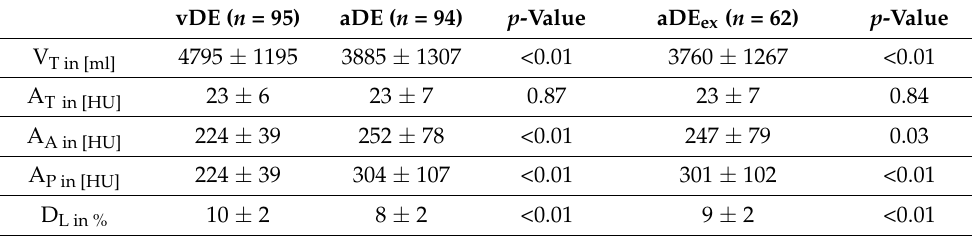
Table 2. Objective image quality of the study (vDE—portal-venous thoraco-abdominal Dual Energy CT), the reference (aDE—pulmonary arterial Dual Energy CT), and the subgroup of the reference with exclusion of cases with pulmonary embolism (aDEex): Total lung volume (VT); mean relative attenuation of the lung parenchyma (AT), ascending aorta (AA), and pulmonary trunk (AP); and distribution ratio (DL) of contrast agent between the large vessels and the lung parenchyma. vDE ( n = 95) aDE ( n = 94) p -Value aDE ex ( n = 62) p -Value V T in [ml] 4795 ± 1195 3885 ± 1307 <0.01 3760 ± 1267 <0.01 A T in [HU] 23 ± 6 23 ± 7